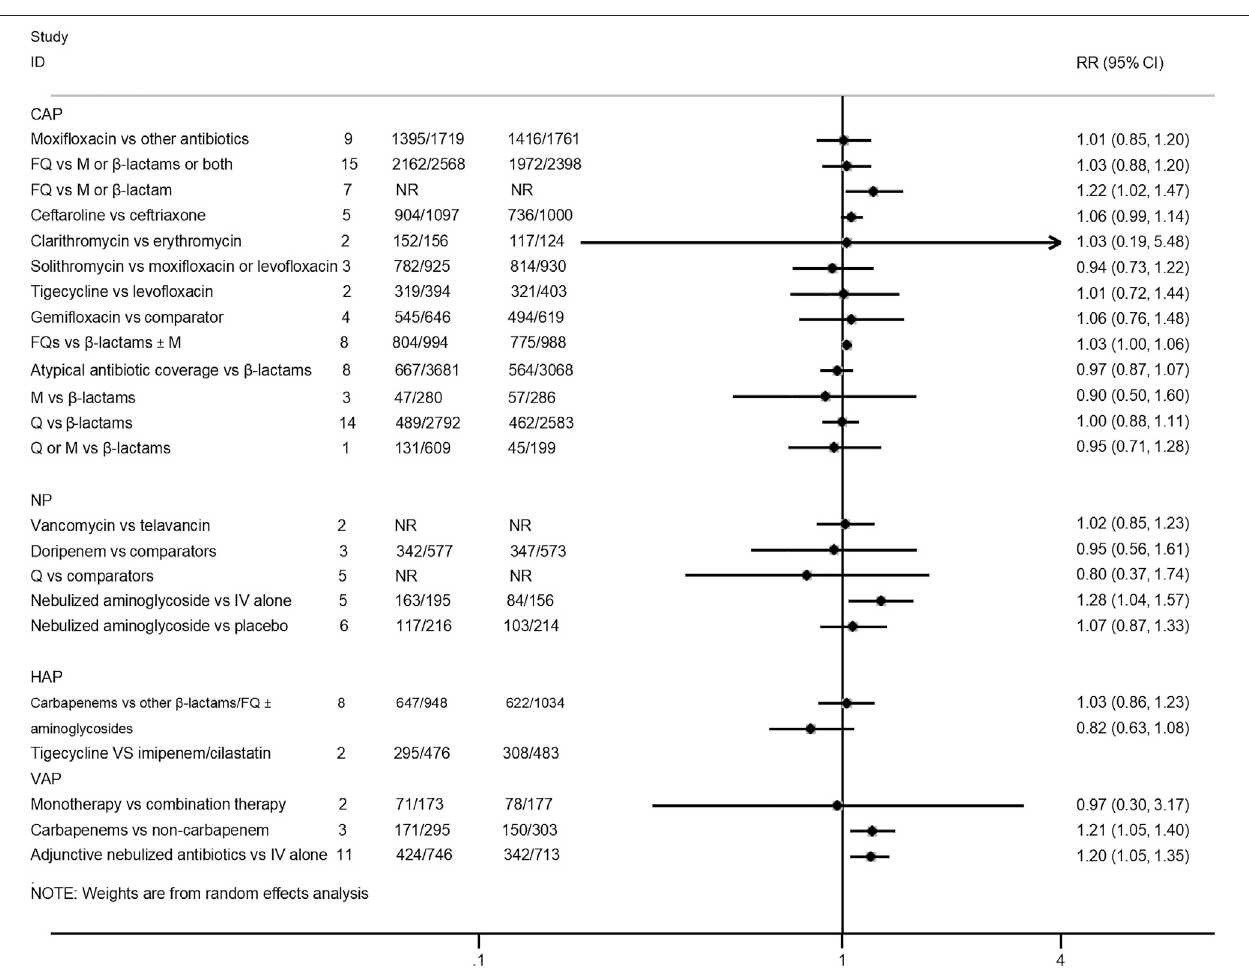
FIGURE 3 | Clinical treatment success analysis based on intention-to-treat population.